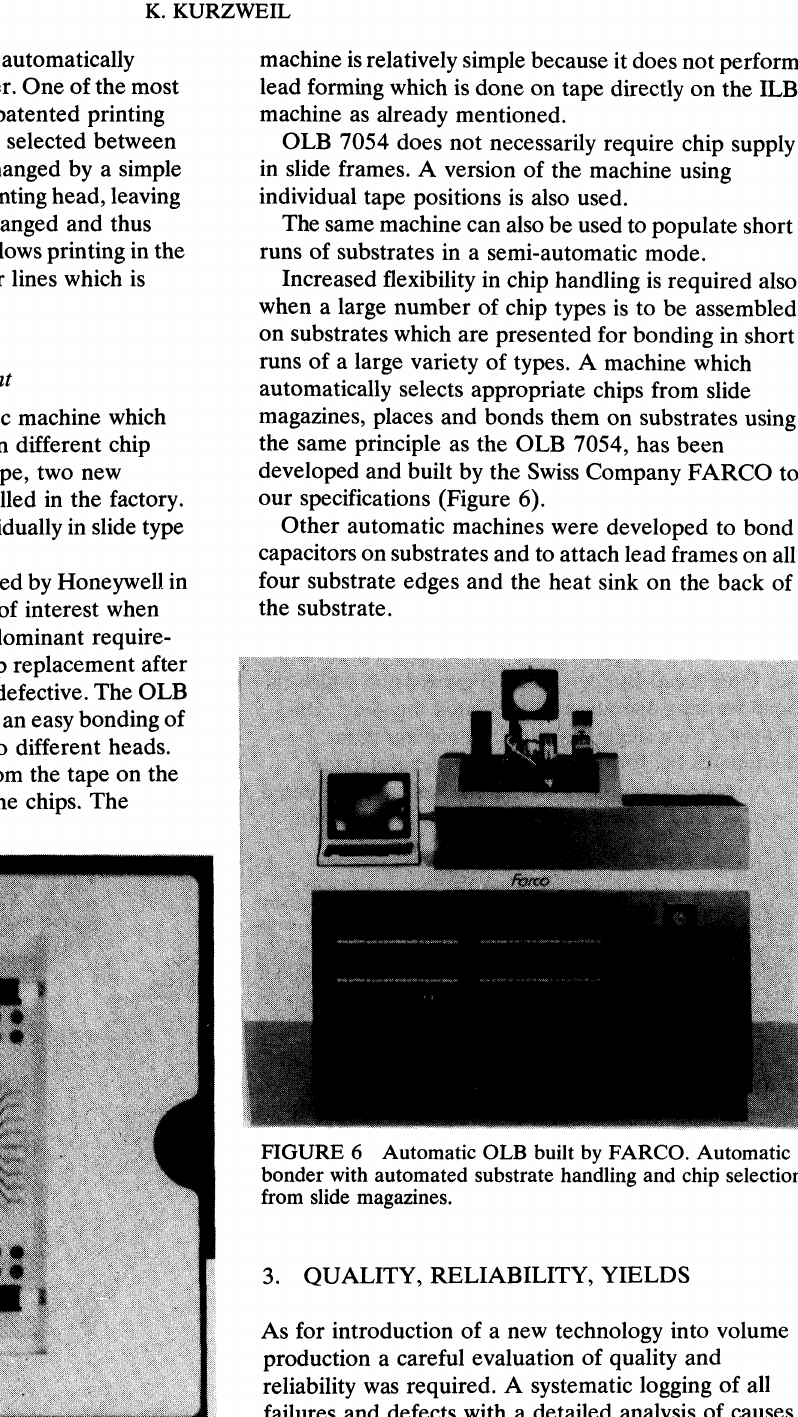
FIGURE 6 Automatic OLB built by FARCO. Automatic bonder with automated substrate handling and chip selection from slide